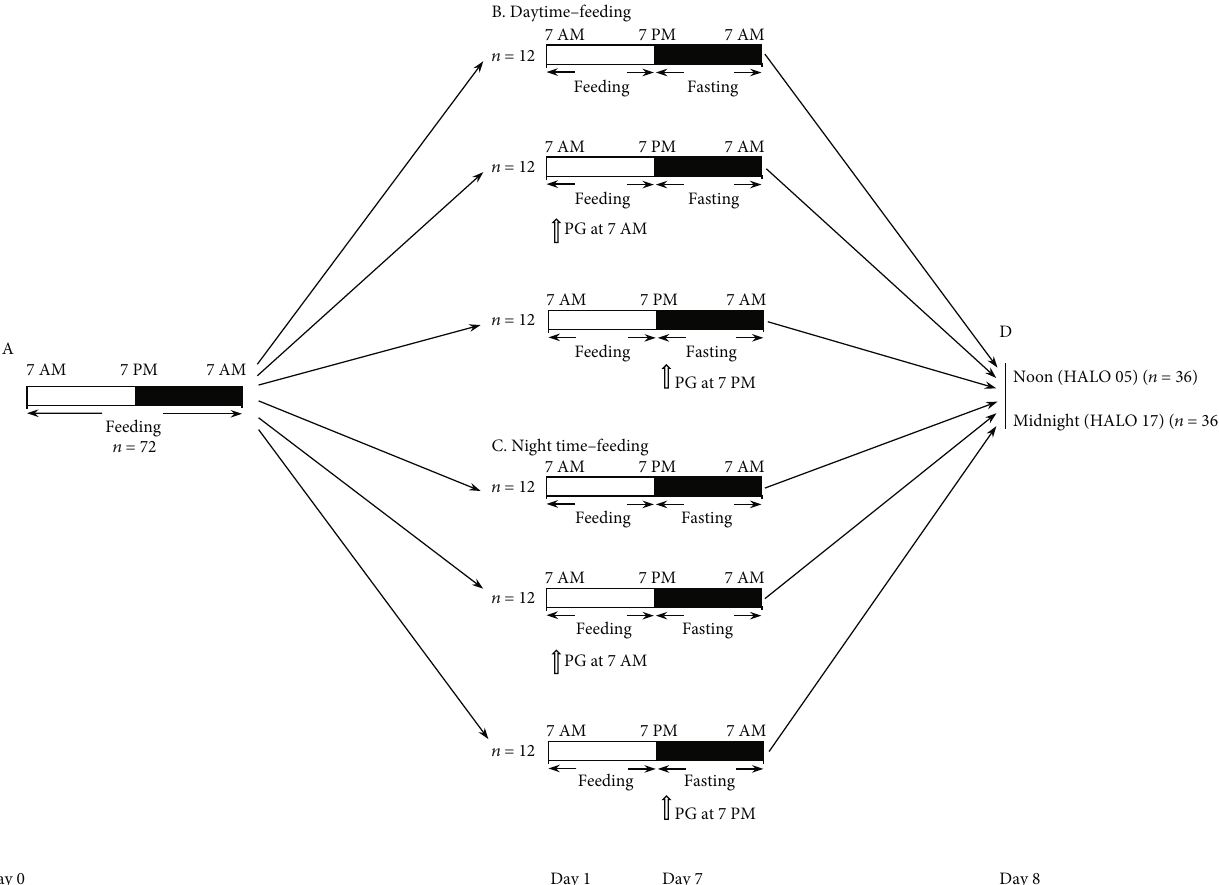
Figure 1: Experimental fl owchart. Open and solid bars indicate light and dark periods, respectively. Solid lines indicate feeding and fasting periods. Experimental schedule from day 0 to day 8: (a) mice entrained to a 12-h light-dark cycle with ad libitum access to food and water; (b) mice in daytime-feeding groups; and (c) mice in nighttime-feeding groups. (d) Sacri fi cation was performed at day 8 noon (HALO 05) and midnight (HALO 17), and liver specimens and serum samples were collected. Sacri fi cation for histopathological analysis and Western blotting was performed at HALO 05. White arrows indicate the time of pioglitazone